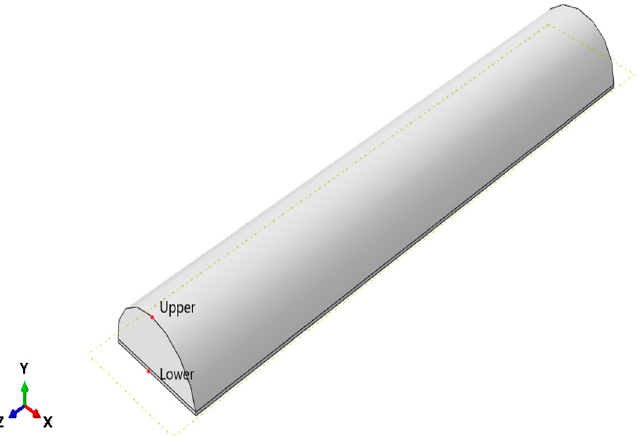
Figure 16. Points where sensors are defined to extract the displacement.